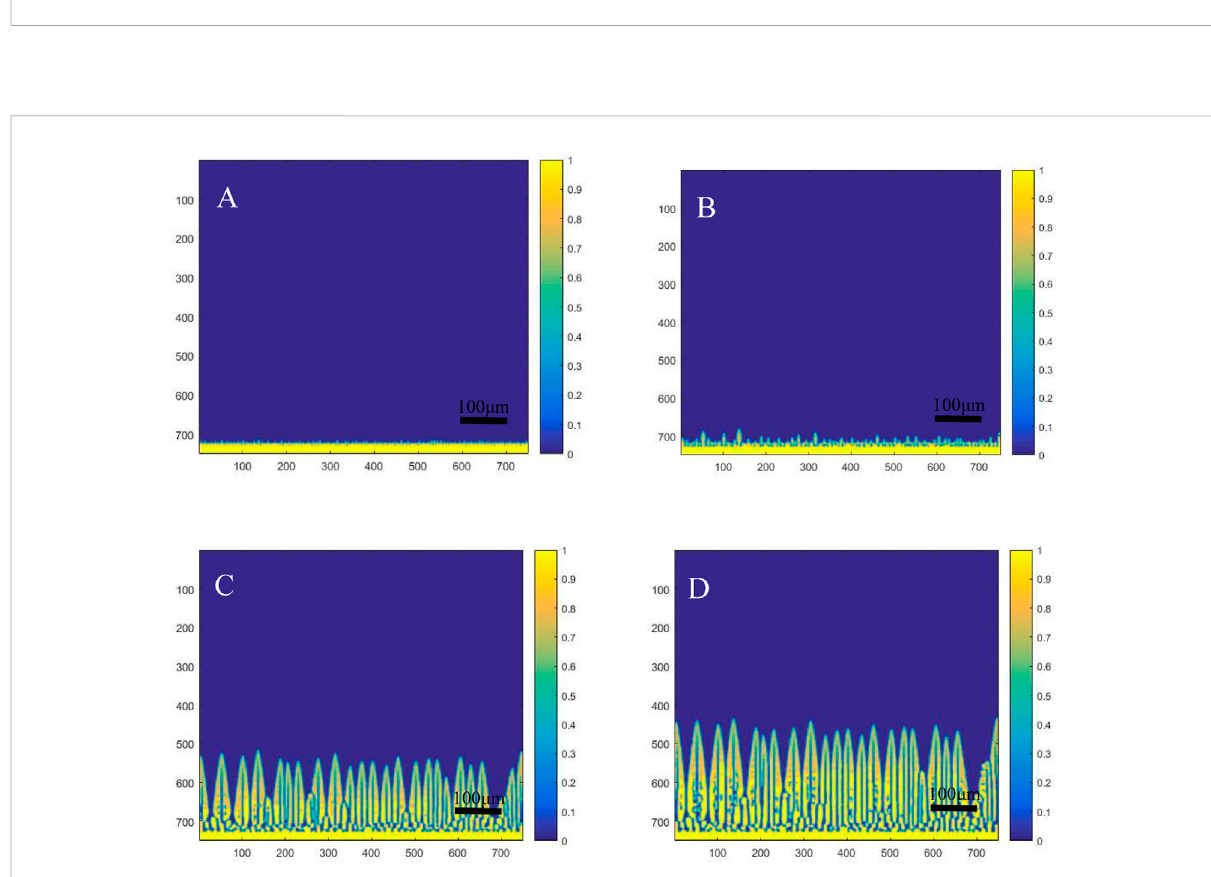
The dendrites growth of directional solidi fi cation at different stages: (A) 1000 dt; (B) 2000 dt; (C) 4000 dt; (D) 6000